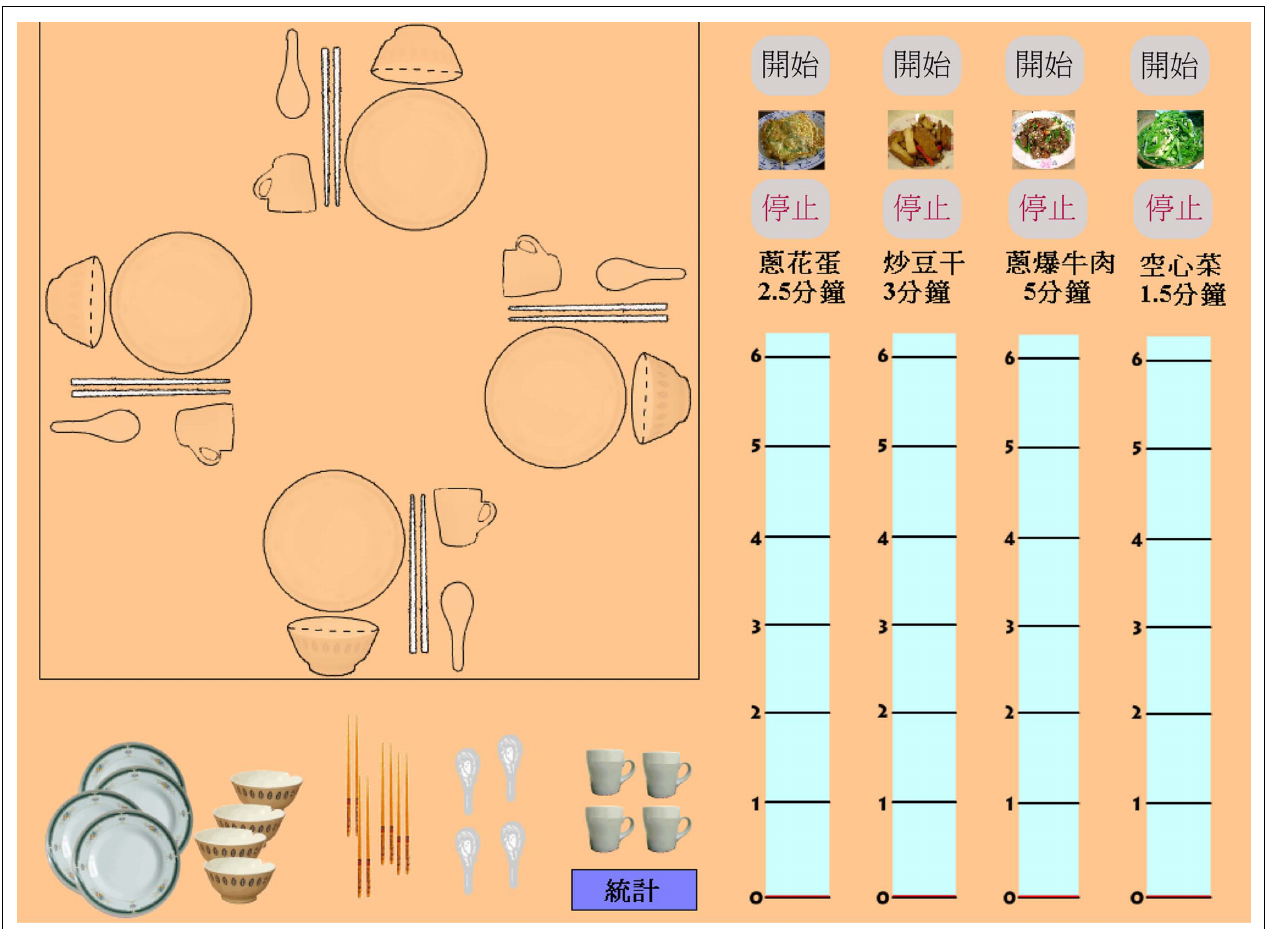
FIGURE 1 | Illustration of the training task screen. Right: cooking was the primary task. Participants controlled the start and stop time of cooking. Left: table setting was the secondary task. Participants moved the dinnerware to their respective locations in the four places.